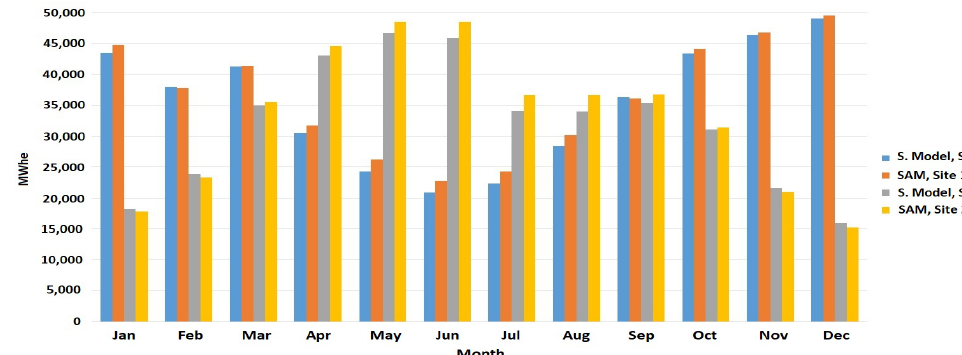
Figure 11. Monthly net production of electric power.